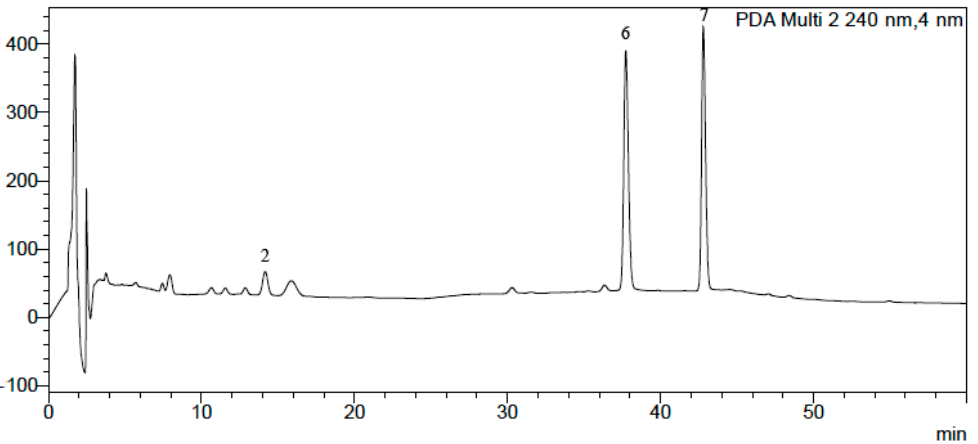
Figure 3. HPLC-DAD chromatogram obtained for Macleaya cordata leaves. For abbreviations, see Figure